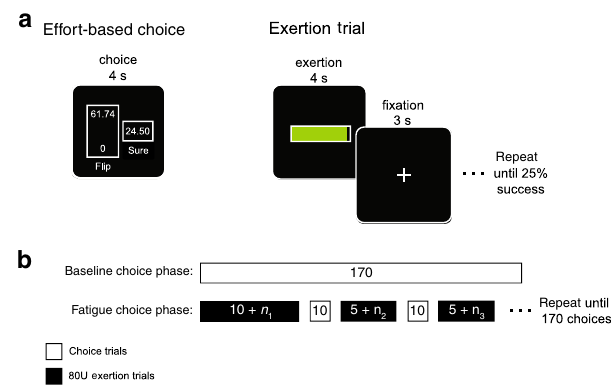
Fig. 1 Experimental design. a During effort-based choice trials participants were presented with a series of choices between a risky option that could result in either a large level of exertion or no exertion with equal probability (Flip), or exerting a lower level of effort with certainty (Sure). The effort amounts were presented on a 0 to 100 scale, which participants were trained on during an association phase prior to choice. An effort level of zero corresponded to no exertion and 100 to 80% of a participant ’ s maximum exertion. To study the effects of fatigue on effort-based decision- making, blocks of exertion trials were interspersed with blocks of effort- based choice trials. During exertion trials, participants exerted grip force on a hand dynamometer to fi ll a horizontal bar, where the full bar corresponded to an effort level of 80. b Experiment schedule. The experiment was divided into baseline and fatigue choice phases, which were both scanned with fMRI. The baseline choice phase consisted of 170 effort-based choices presented in a randomized order. Following the baseline choice phase, participants performed the fatigue choice phase of the experiment, in which they underwent repeated exertion trials (indicated in black) to bring them into a fatigued state. The fatigue choice phase began with an initial exertion block, comprised of a minimum of ten repetitions of exertion, followed by alternating choice (shown in white) and exertion blocks. Exertion trials in a block were repeated until 75% of trials within an exertion block were counted as failures ( n i indicates the variable additional number of repetitions before participants reached the failure criteria). Each choice block consisted of 10 effort-based choices randomly sampled from the same set used in the baseline choice phase. Subsequent exertion blocks were identical to the fi rst, differing only in that they were comprised of a minimum of 5 trials. Completion of the fatigue choice phase consisted of